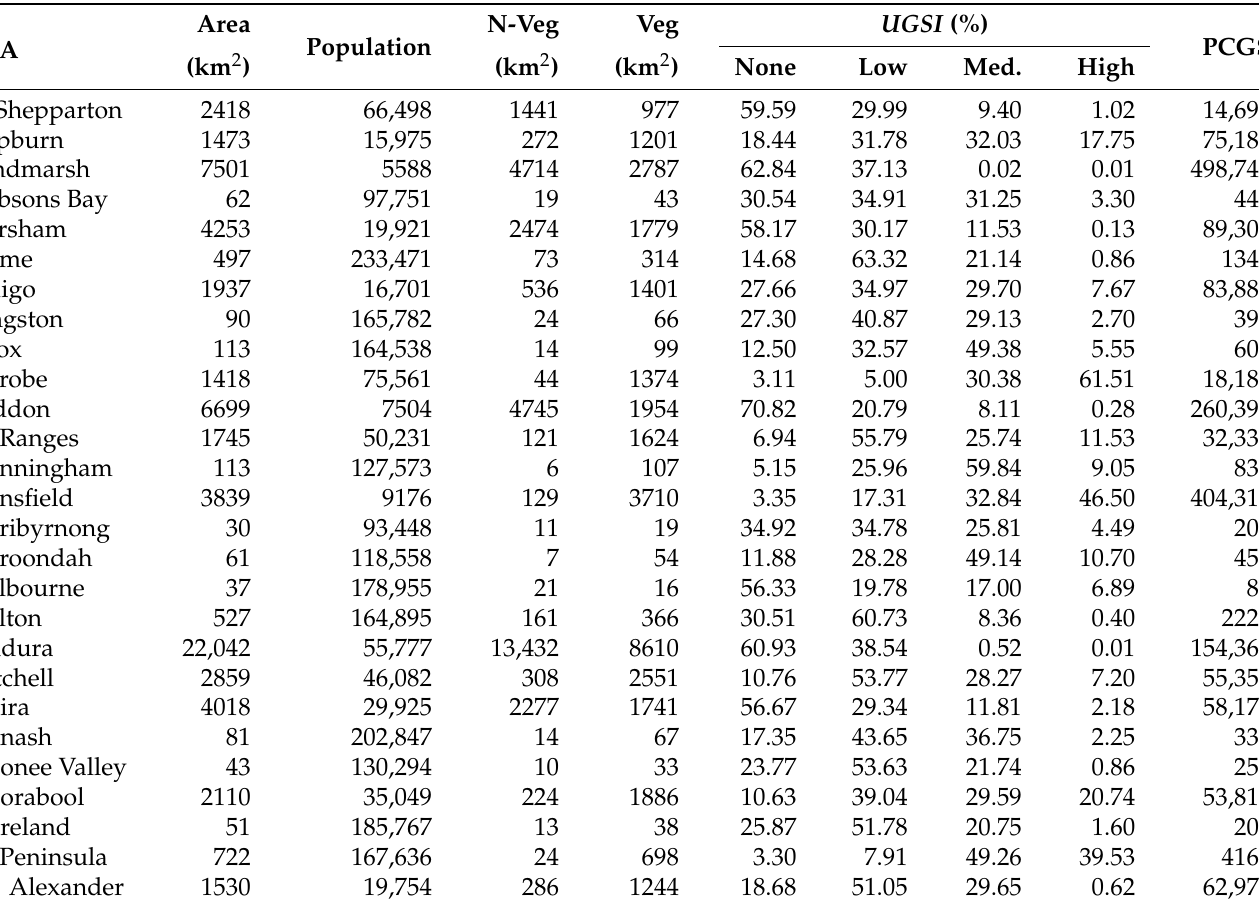
Table 12. Urban Green Space Index ( UGSI ) and Per Capita Green Space ( PCGS ) calculation of different LGAs of Victoria, Australia. Note that the unit of PCGS is m 2